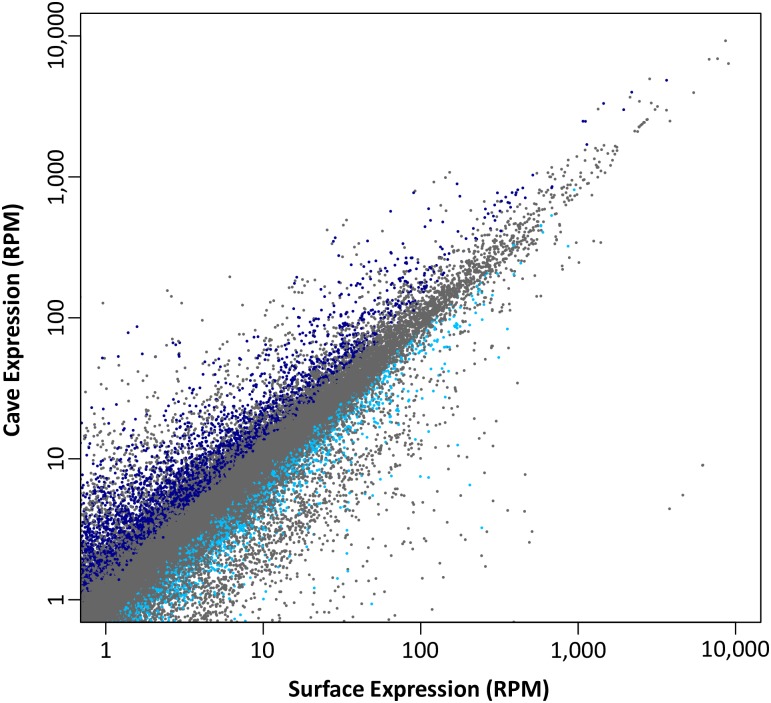
Scatterplot of the averages of standardized expression levels (RPM = reads per million mapped reads) in four cave versus four surface specimens for all 104,630 transcripts in the transcriptome assembly (R2 = 0.85).A greater number of transcripts had higher expression in the cave population than in the surface population (59,571 versus 45,069, respectively). Data points from transcripts with significantly different levels of expression in the cave and surface populations are labeled in color (dark blue = cave upregulated, light blue = cave downregulated).